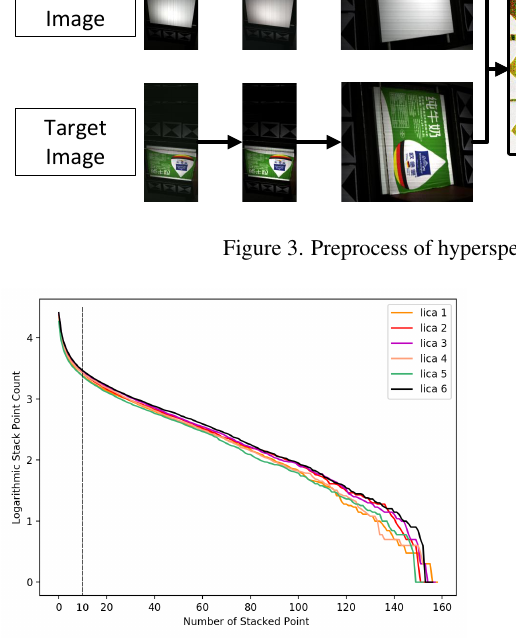
Figure 4. Number of Stack Points with respect to Stack Count puted from the corresponding points selected by hands.